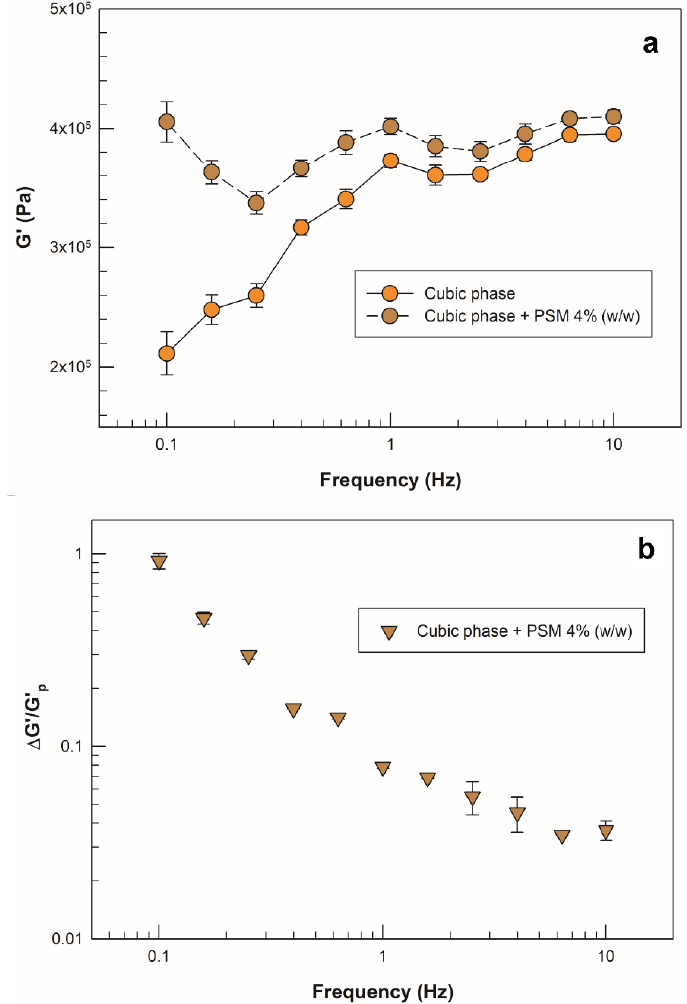
Figure 7. Mucoadhesion assessment with oscillatory frequency sweep analysis. ( a ) Frequency dependence of the elastic modulus (G’) for the drug-loaded cubic phase alone (orange round symbols) and for the mixture with PSM 4% (brown round symbols). ( b ) Frequency dependence of the calculated interaction term ( ∆ G’/ G’) for the mixture of drug-loaded cubic phase with PSM (brown triangular symbols). All samples were swelled in SVF. The results are reported as mean values ± standard deviation; the error bars, if not shown, are smaller than the symbol size.